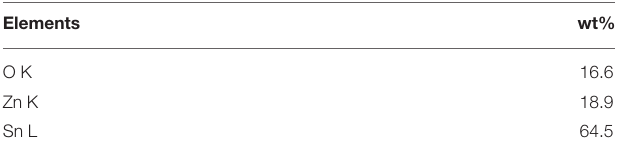
TABLE 1 | Element contents of SnO 2 /ZnO composite